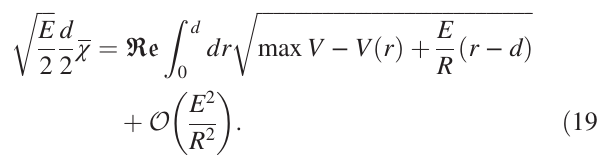
=R → 0 limit of the c =R c